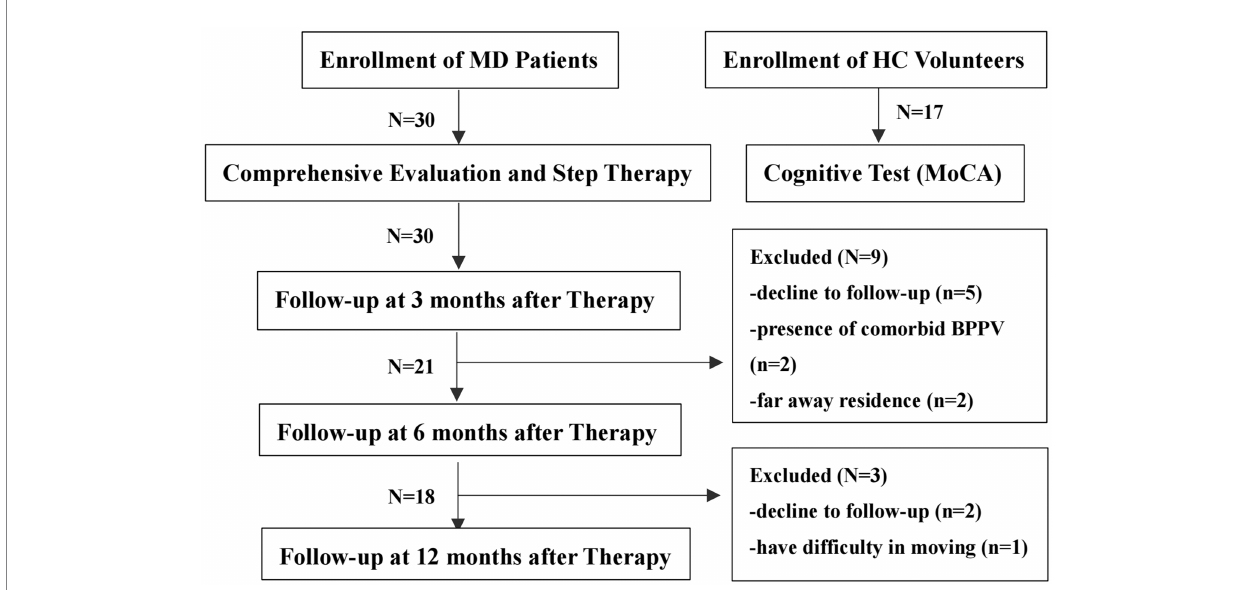
FIGURE 1 Study procedure and exclusion of participants. MD, meniere’s disease, HC, healthy controls; and MoCA, montreal cognitive